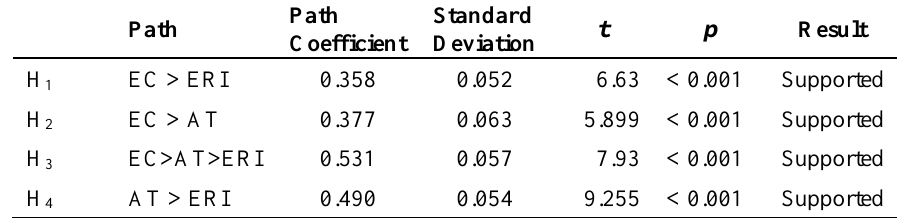
Table 3: Results of Primary Hypotheses